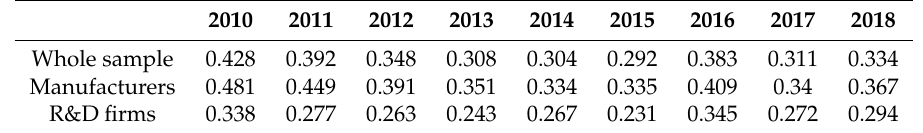
Table 3. E ffi ciency in the pharma and biotechnological European industry by activity, yearly results,